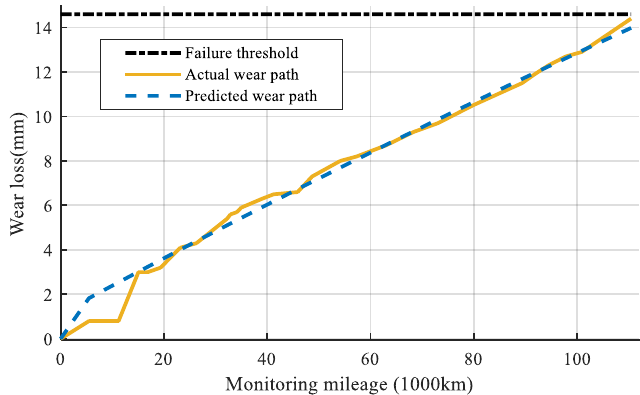
Figure 14. The actual wear path and predicted wear path of sample 2.